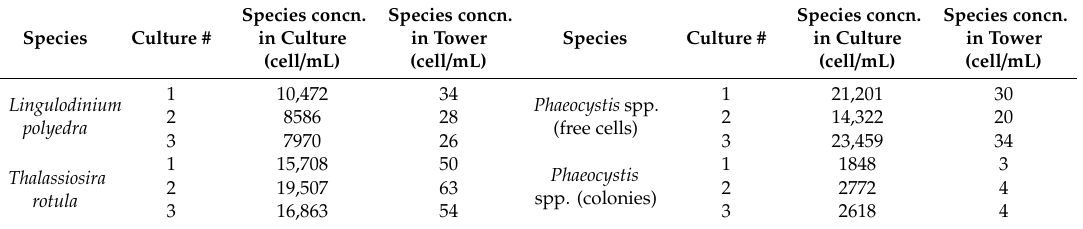
Table 2. Initial phytoplankton cell counts in cultures and resulting diluted concentrations in the towers.